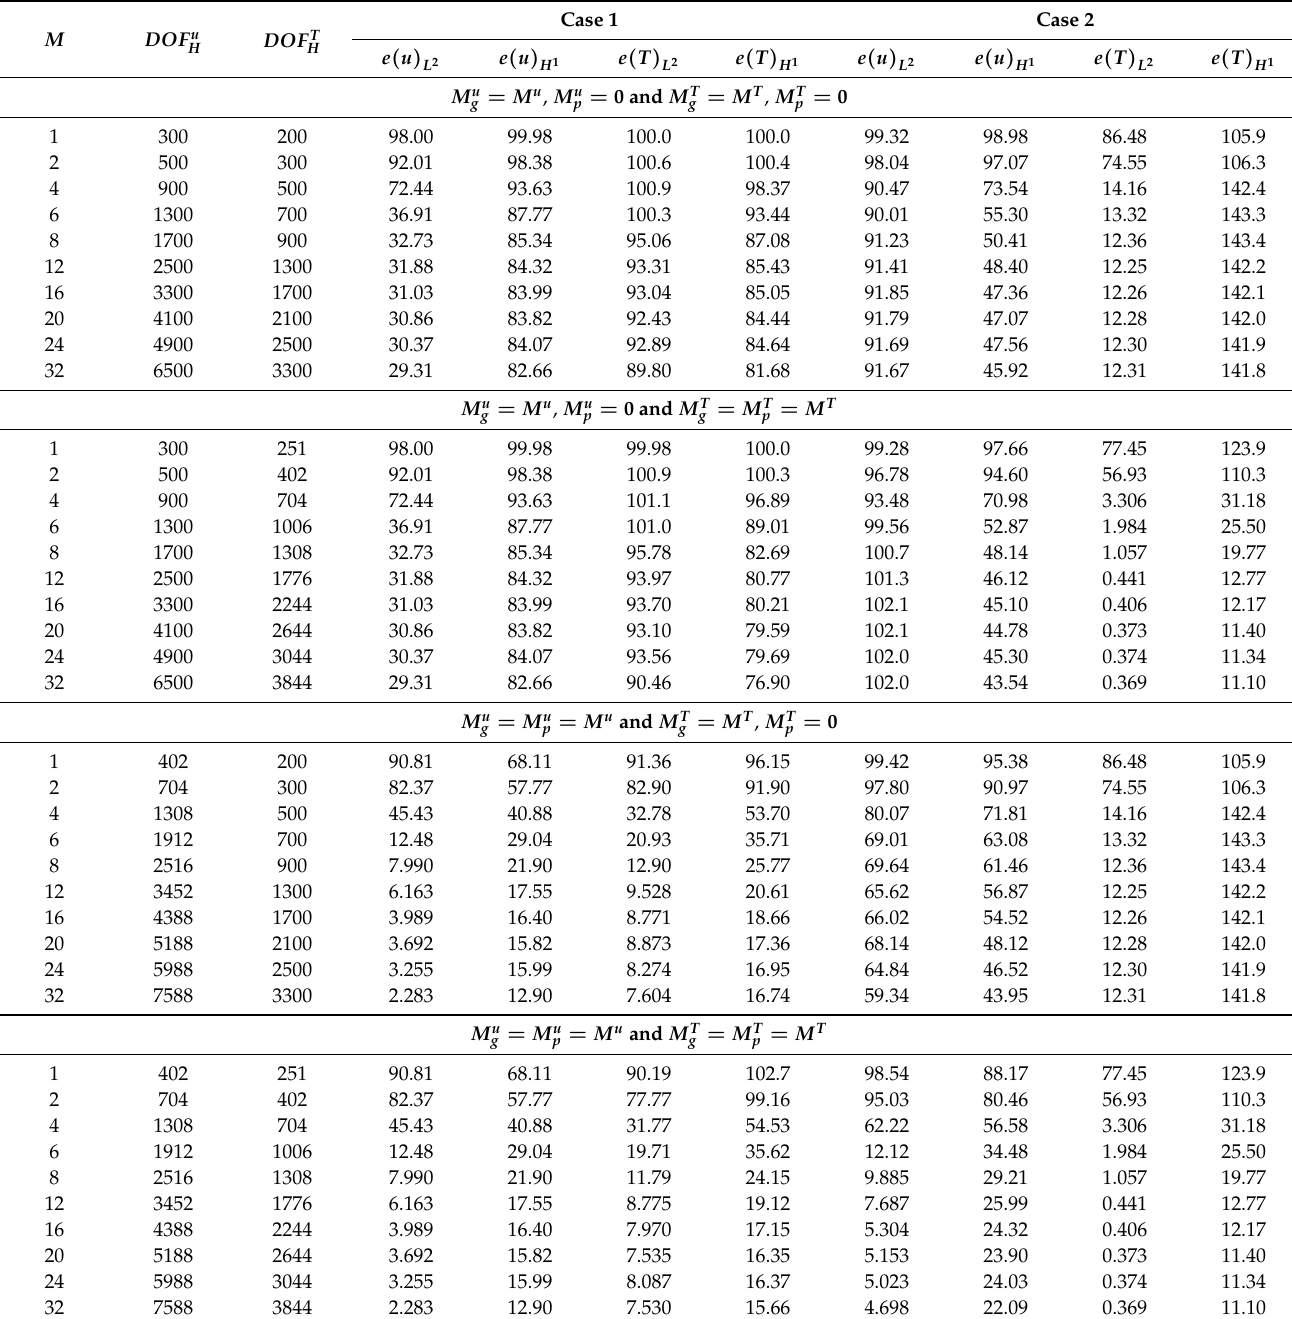
Table A4. Thermoelasticity problem. Case 1 and Case 2. M = M u = M T . Relative L 2 and H 1 error in %. DOF h =